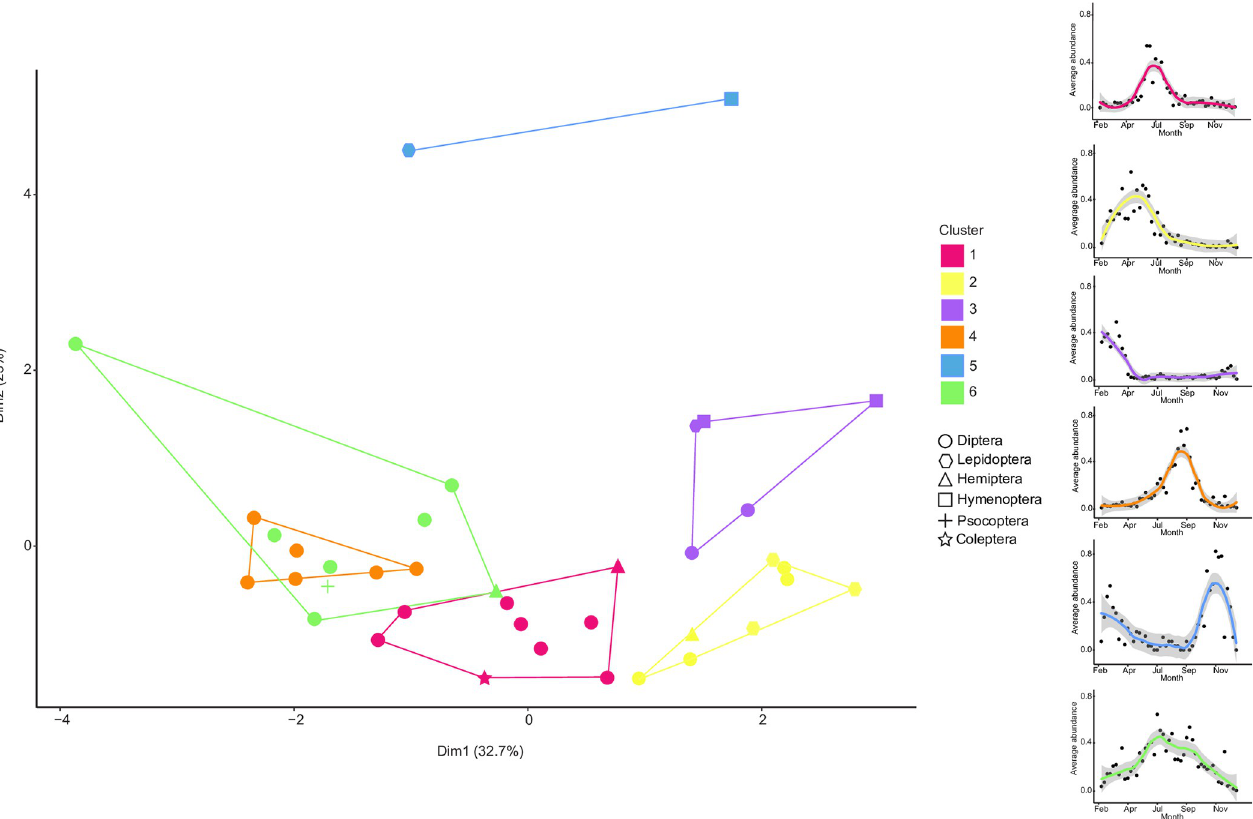
Fig 5. Cluster plot following a k-means analysis using the algorithm of Hartigan and Wong [69]. The 38 most common BINs were grouped into six clusters based on their abundance distributions over the year. The insets to the right show the abundance distribution pattern of each cluster throughout the year (see S7 Fig for more